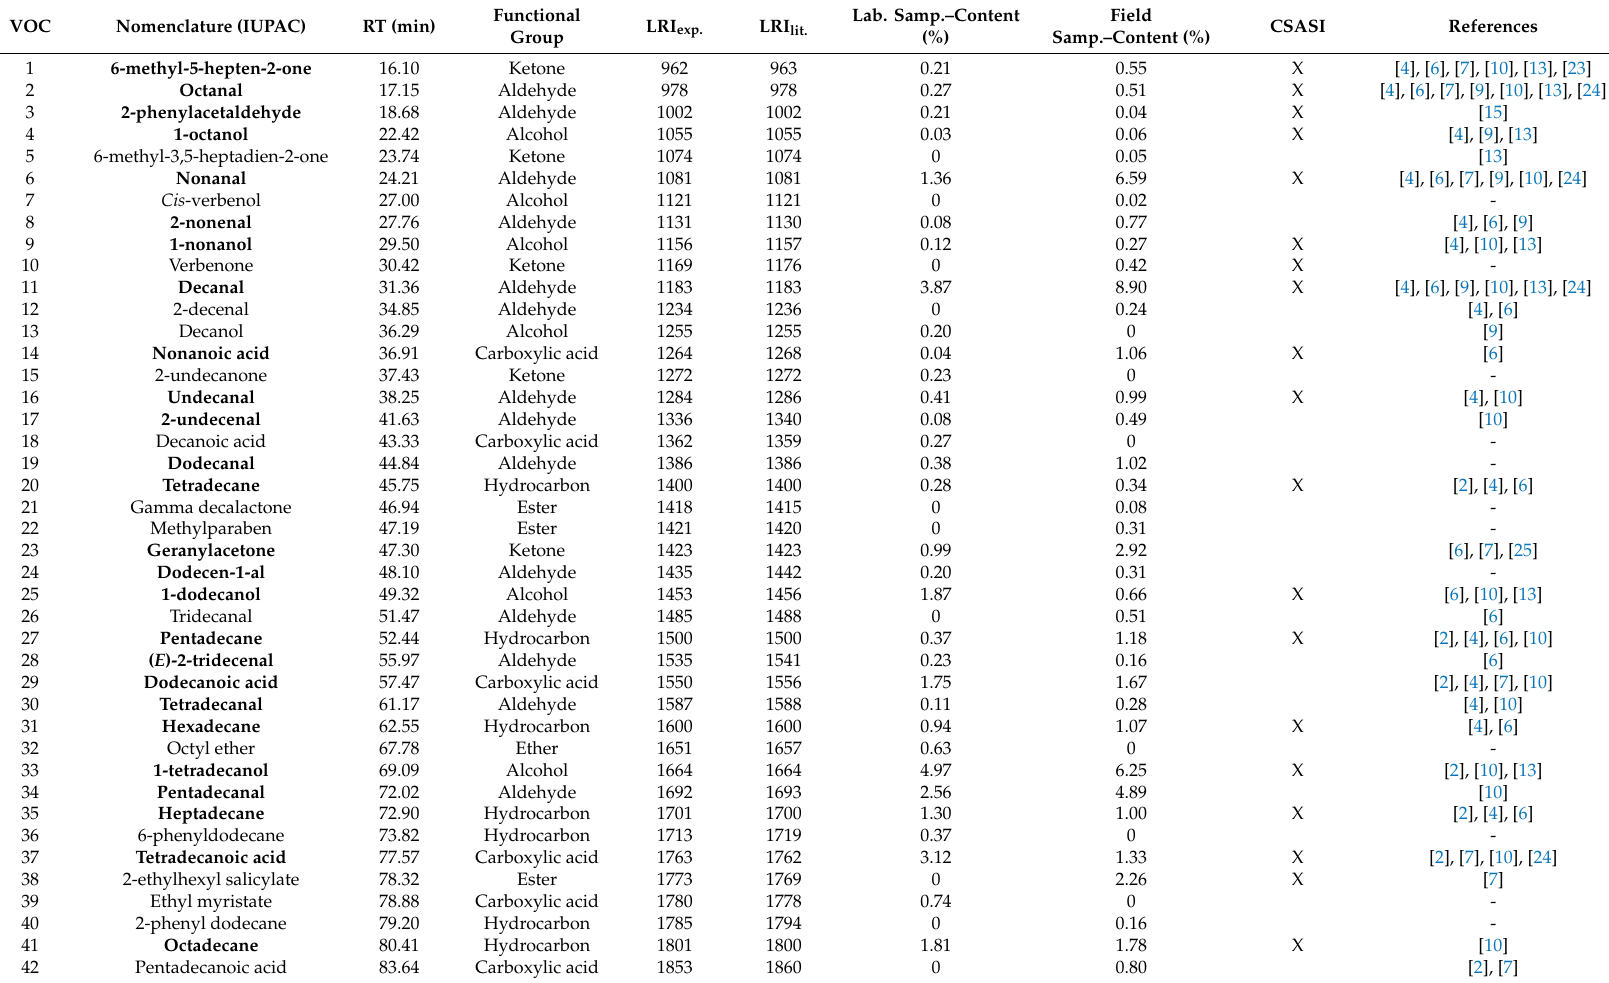
Table 1. List of the identified volatile organic compounds (VOCs) obtained by SPME-HS / GC-MS analysis of hair samples acquired during laboratory sampling and field